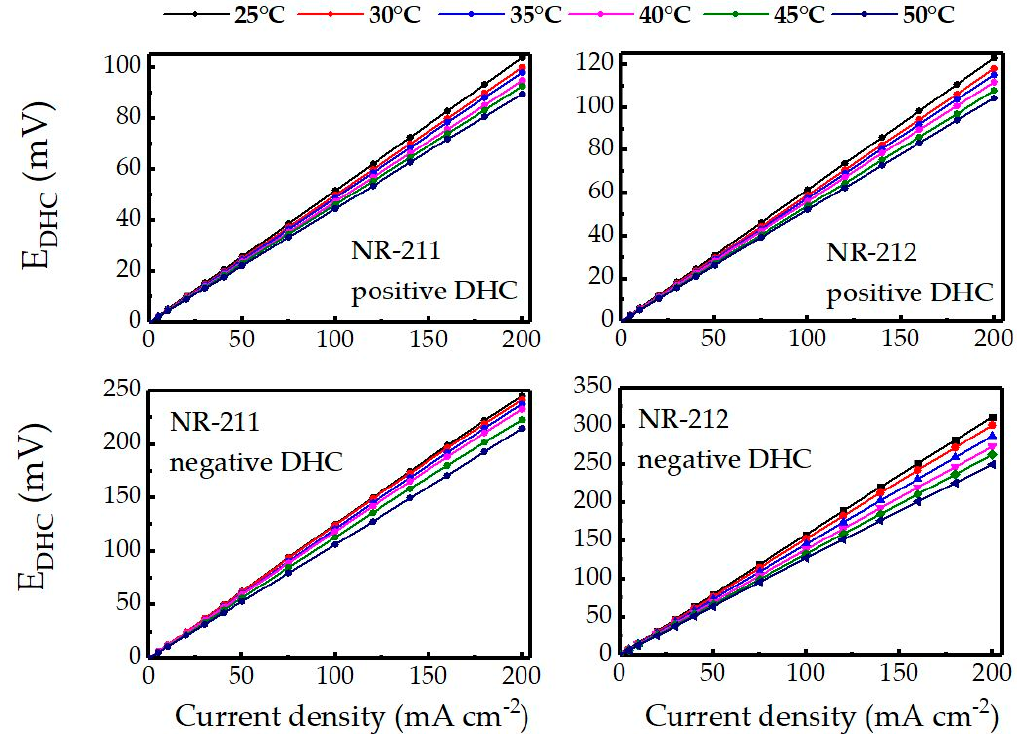
Figure 3. Double half-cell measurements (DHC) polarization curves using positive and negative electrolytes (1.6 M vanadium, both at SOC = 50%) and Nafion ® NR-211 and NR-211 membranes at operating temperatures ranging from 25 °C to 50 °C.